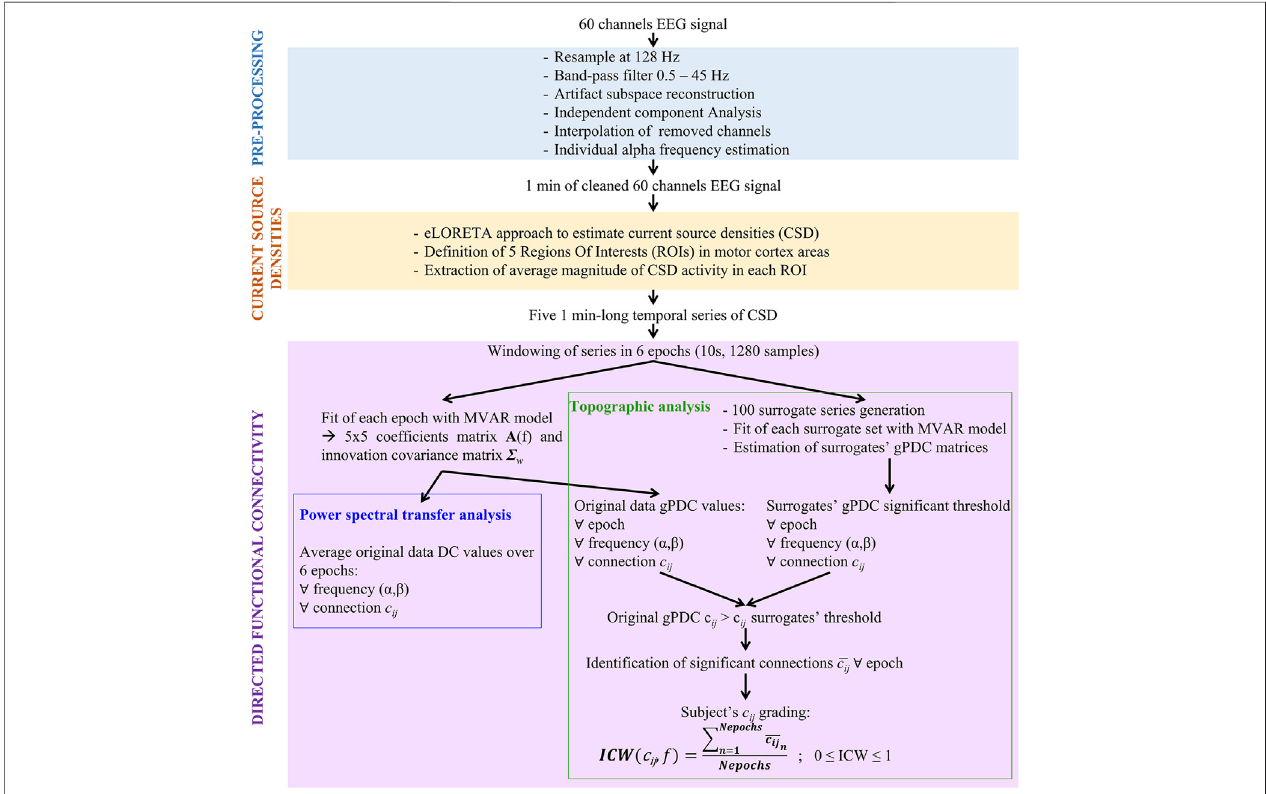
FIGURE 1 | Pipeline of single acquisition and analysis. Abbreviations: MVAR, multivariate auto-regressive; DC, Directed Coherence; gPDC, generalized partial directed coherence.